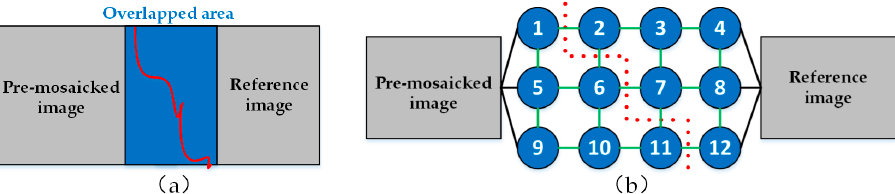
Figure 3. Images and construct of graph. ( a ) An analog seam-line in the overlapping area of adjacent images. ( b ) Diagram of a graph structure. images. ( b ) Diagram of a graph